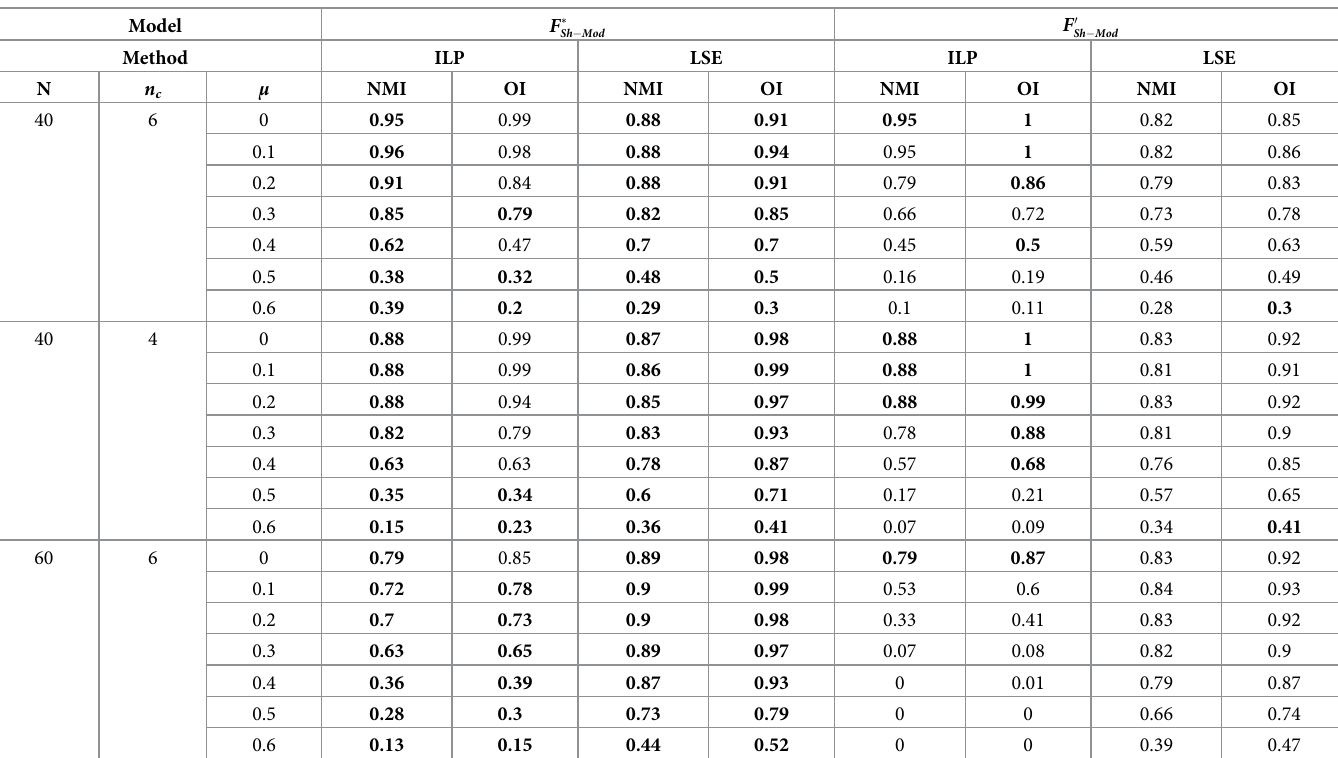
Table 2. Computational results about networks with non-overlapping communities. Model